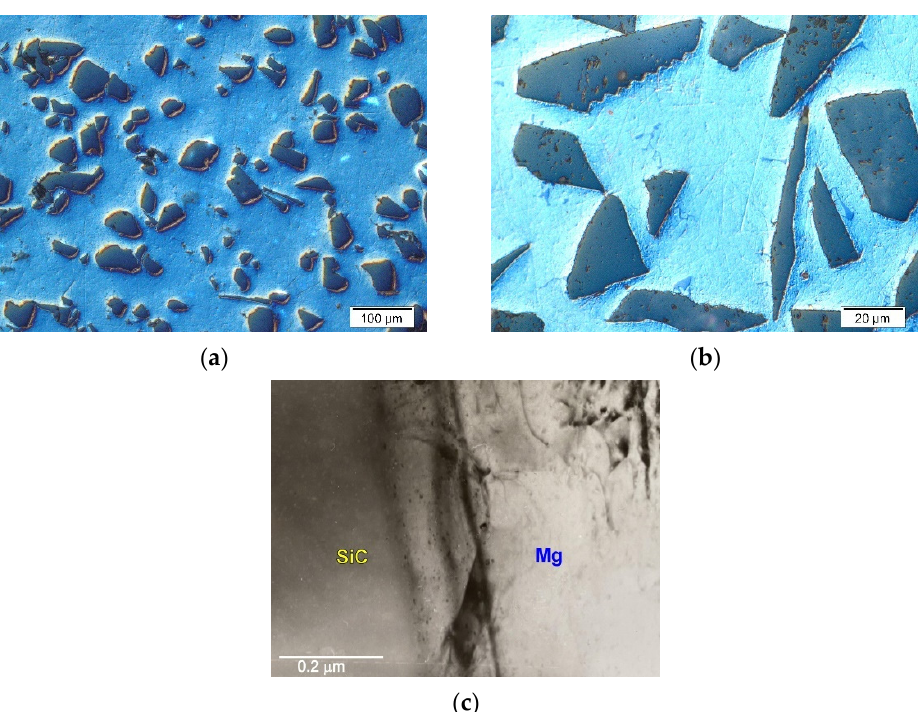
Figure 1. Microstructure of technically pure magnesium matrix composites with SiC particles. ( a , b ) Micrographs taken at different magnification; ( c ) TEM micrograph of interface between compo- nents.